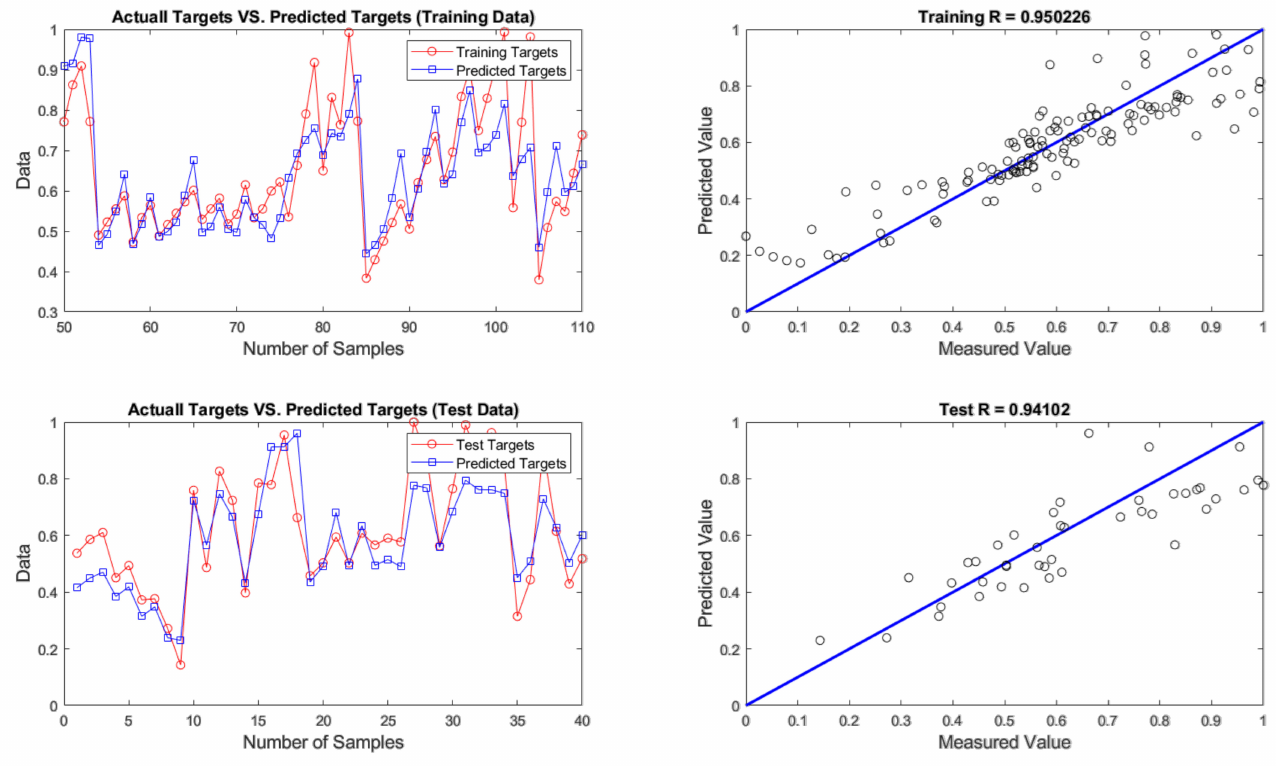
Figure 18. Results of training and testing data for predicting chromium removal using biogeography-based algorithm.